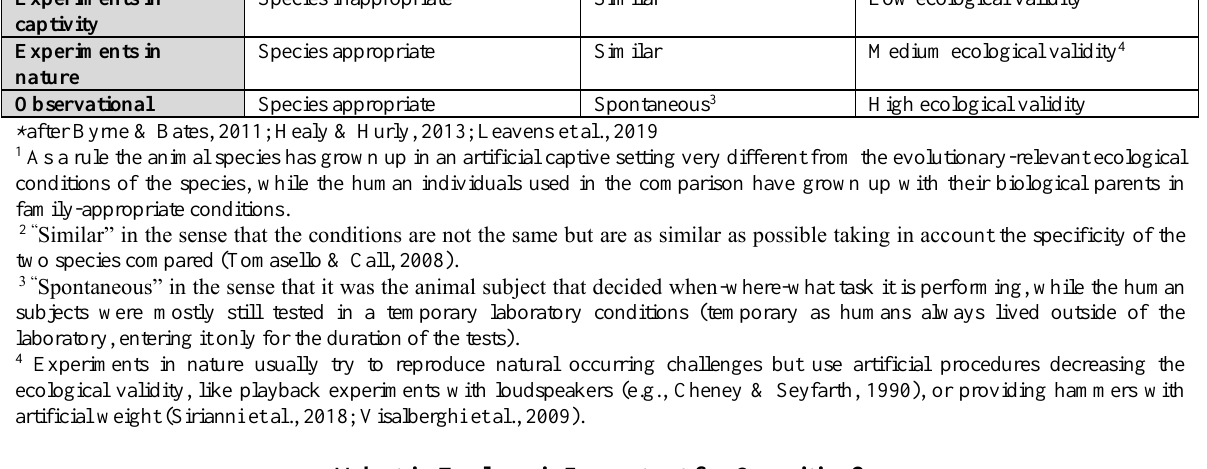
Comparison of the Conditions in Human-Chimpanzee Comparisons when Performed in an Experimental Captive Setting or in an Observational Field Setting* Ontogeny Procedure Cognitive Task Experiments in Species inappropriate 1 Similar 2 Low ecological validity captivity Experiments in Species appropriate Similar Medium ecological validity 4 nature Observational Species appropriate Spontaneous 3 High ecological validity * after Byrne & Bates, 2011; Healy & Hurly, 2013; Leavens et al., 2019 1 As a rule the animal species has grown up in an artificial captive setting very different from the evolutionary-relevant